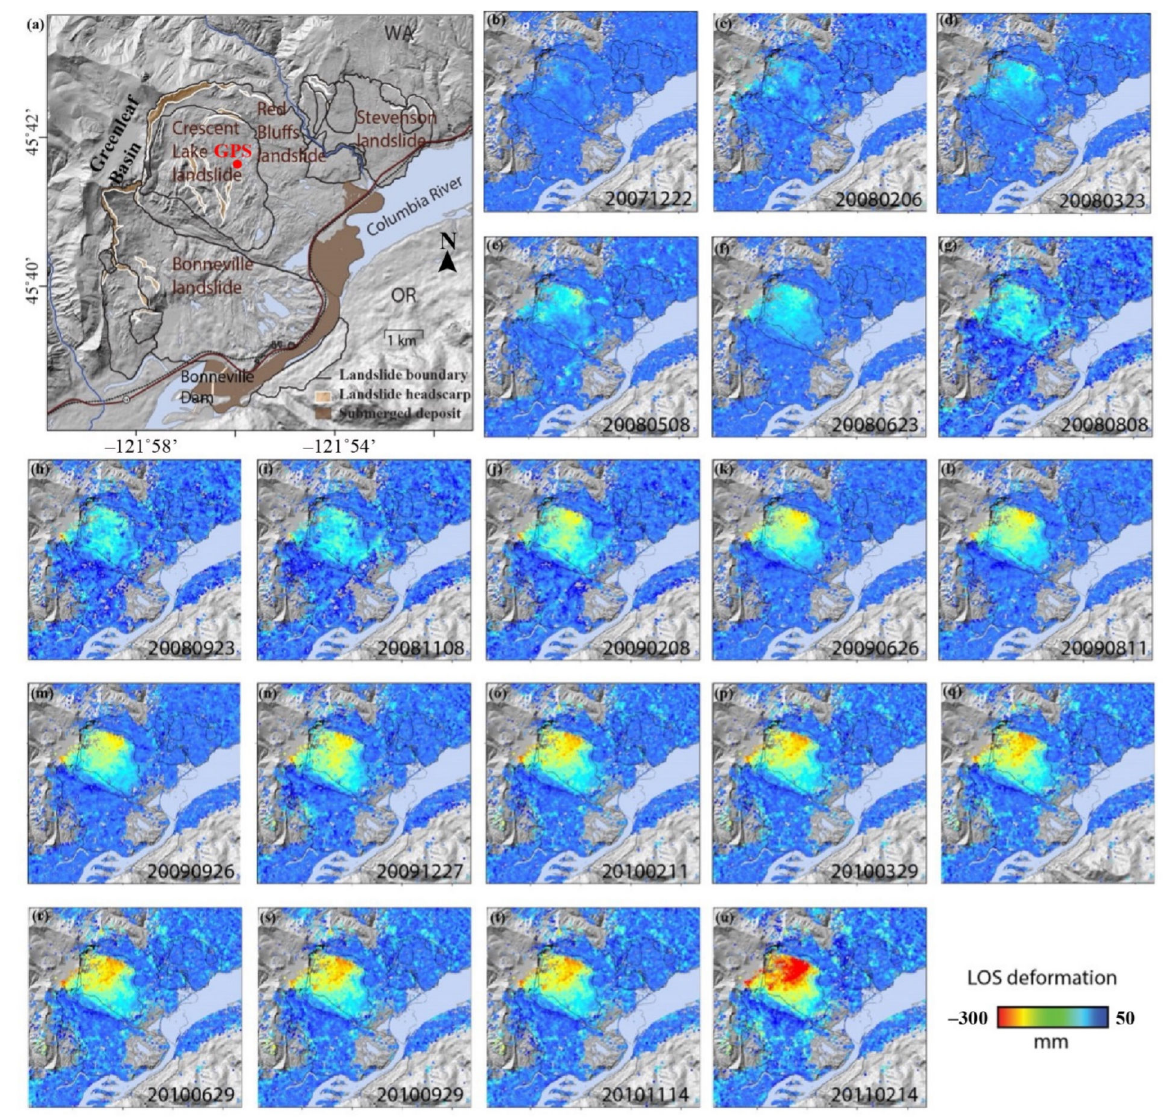
Figure 3. ( a ) Map of Cascade Landslide Complex in Washington (yellow star in Figure 2a), composed of Bonneville landslide, Red Bluff landslide (including the reactivated Crescent Lake landslide), and Stevenson landslide and others. ( b – u ) PSInSAR-derived time-series deformation over the Cascades Landslide Complex along radar line-of-sight (LOS) from ALOS-1 PALSAR-1 during 2007 and 2011 [42]. The color scale shows LOS deformation in mm, with relatively stable areas (within ± 20 mm) in blue. The warm colors (red, yellow) indicate the reactivated portions of the